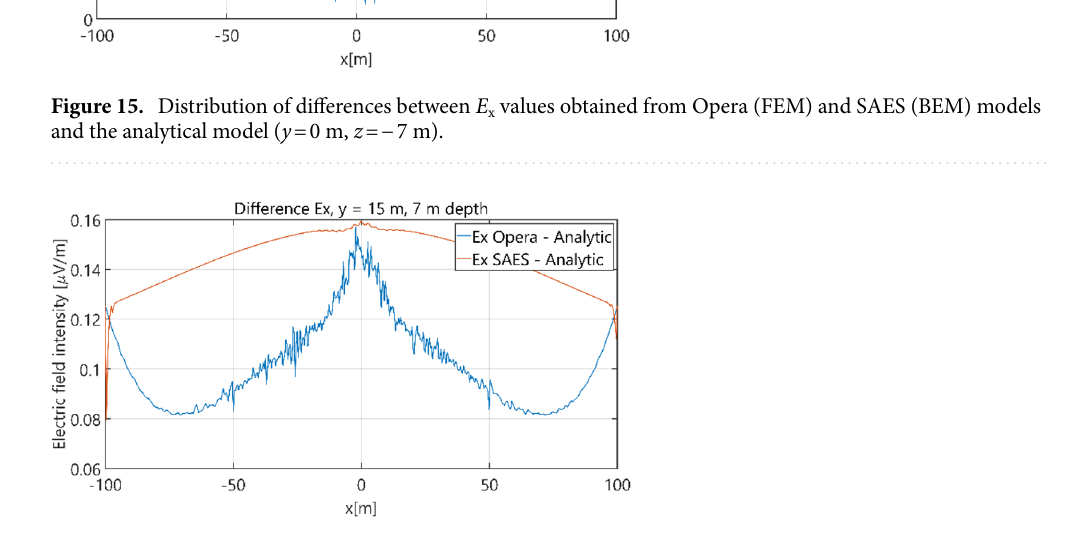
Figure 16. Distribution of differences between E x values obtained from Opera (FEM) and SAES (BEM) models and the analytical model ( y = 15 m, z = − 7 m, case